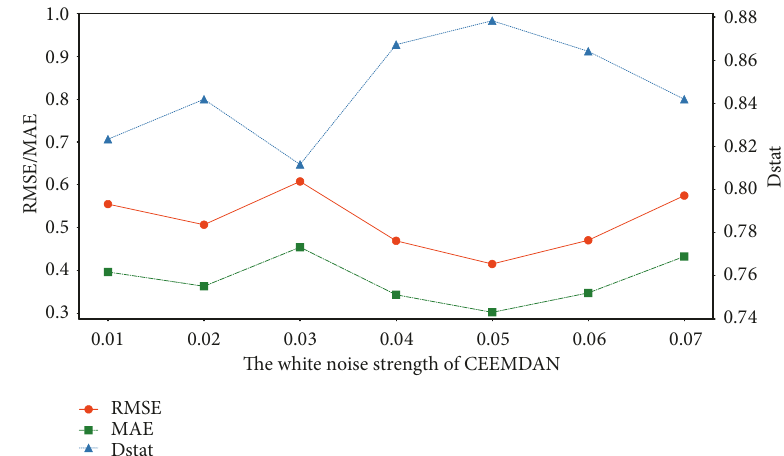
Figure 8: The impact of the value of the white noise of CEEMDAN with